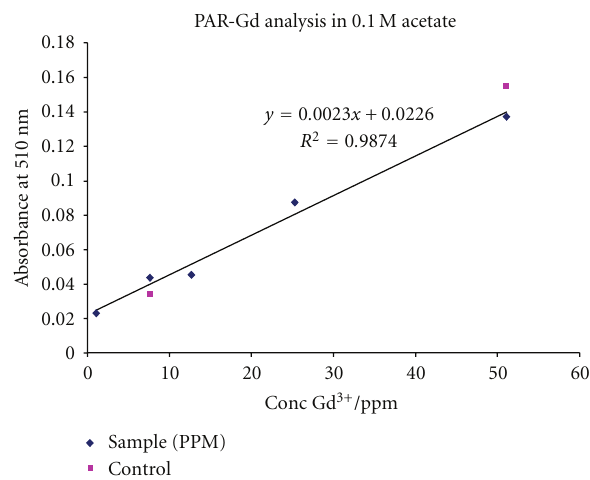
Figure 3: Pyridylazo resorcinol calibration curve used to determine Gd 3+ concentrations in the samples tested for longitudinal relaxiv- ity. The calibration curve was done using a solution of HA spiked with GdCl 3 to simulate the desired matrix for